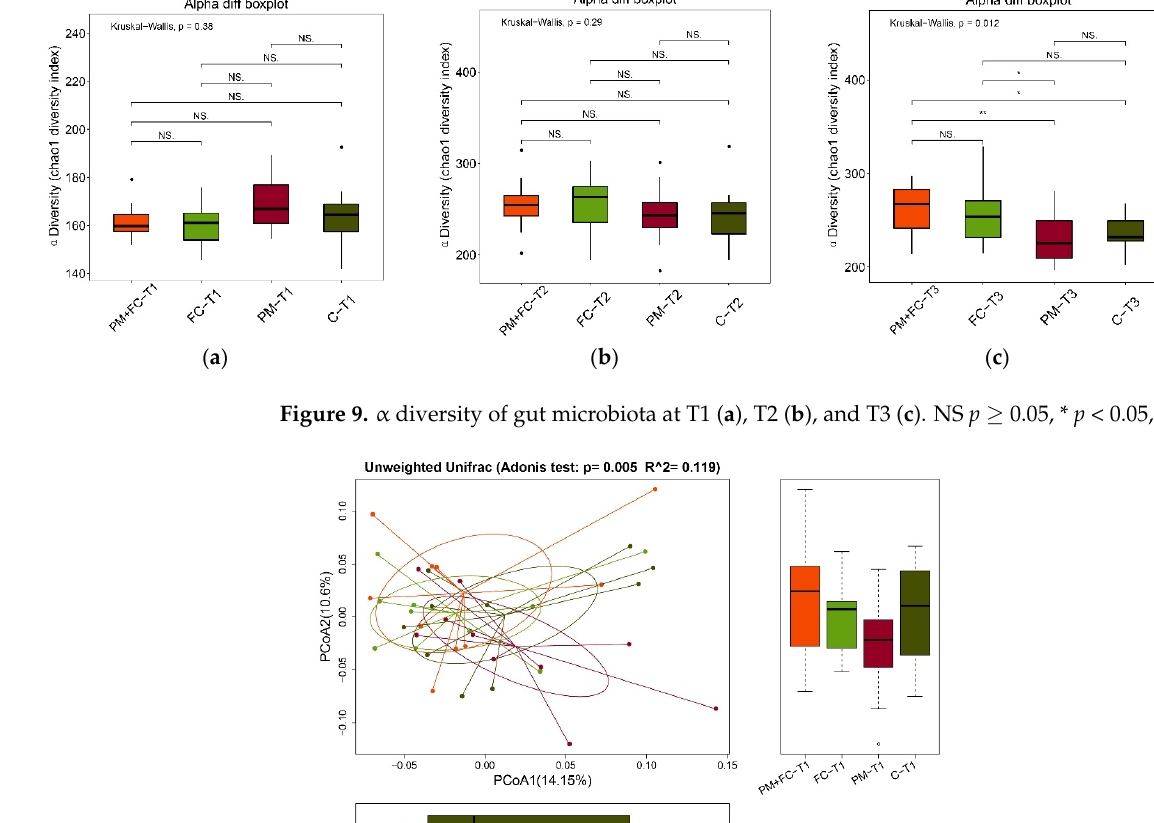
Figure 8. Phylum level barplots of mouse fecal microbiota of four groups (group PM, group PM + FC, group FC, and group C).